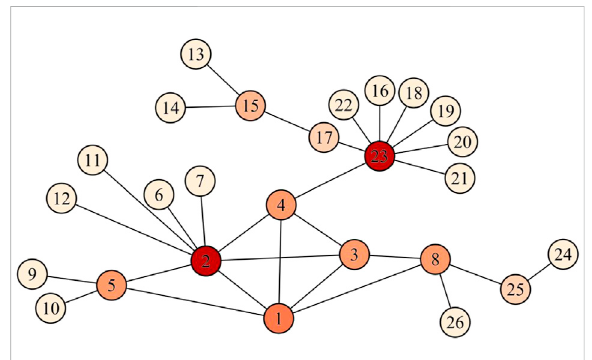
FIGURE 1 An example network to explain DILVoteRank algorithm.